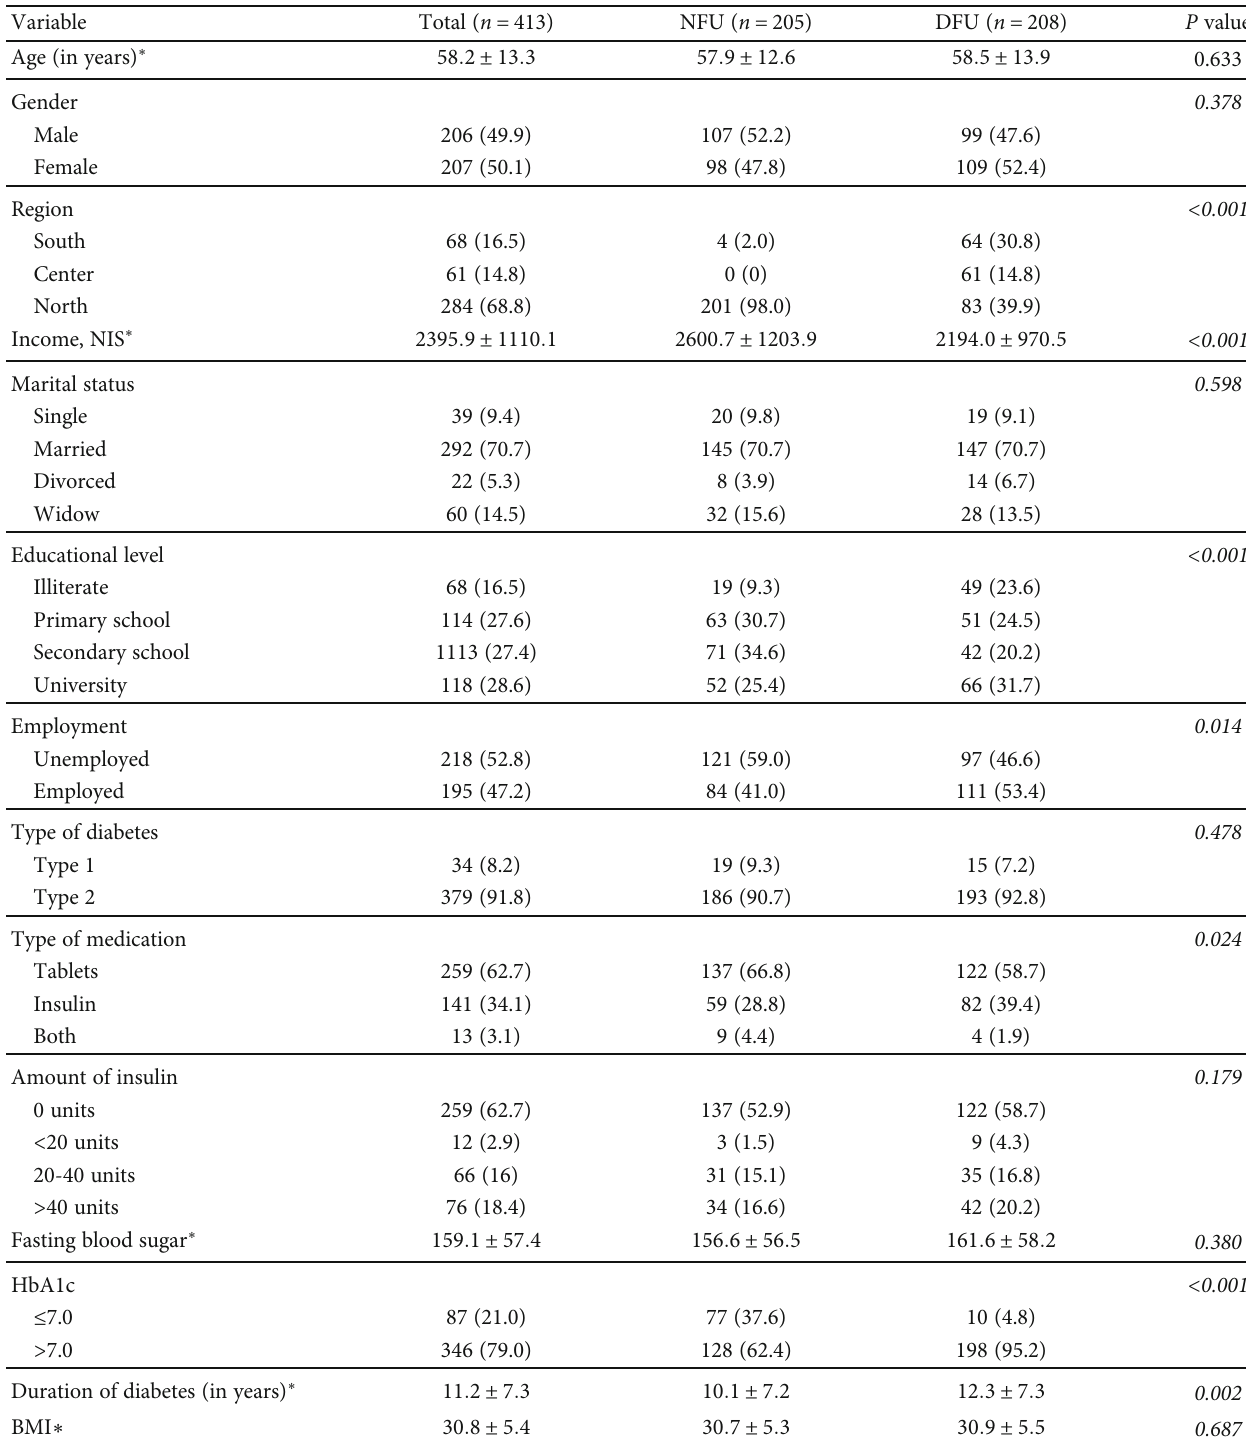
Table 2: Basic characteristics of participants and comparison between DFU (diabetic patients with foot ulceration) and NFU (diabetic patients without foot ulceration)